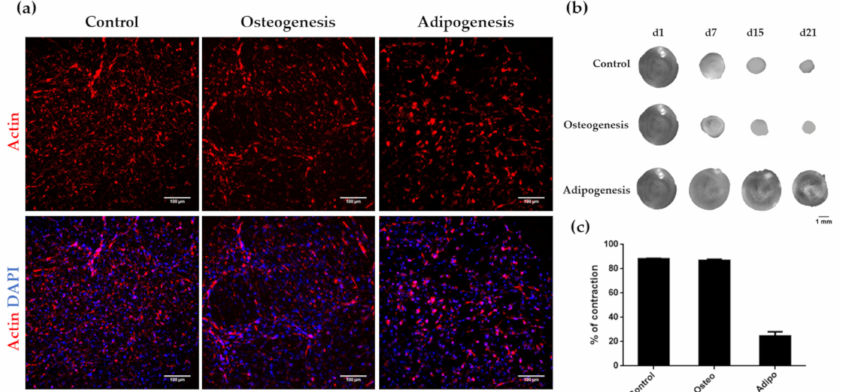
Figure 7. Influence of osteogenic and adipogenic induction on cell morphology and matrix contraction in HFDPC. ( a ) DAPI / Phalloidin staining of 3D cultures under control, osteogenic and adipogenic medium; ( b ) Construct contraction along culture time; ( c ) Contraction degree after 21 days of culture under control, osteogenic and adipogenic medium.